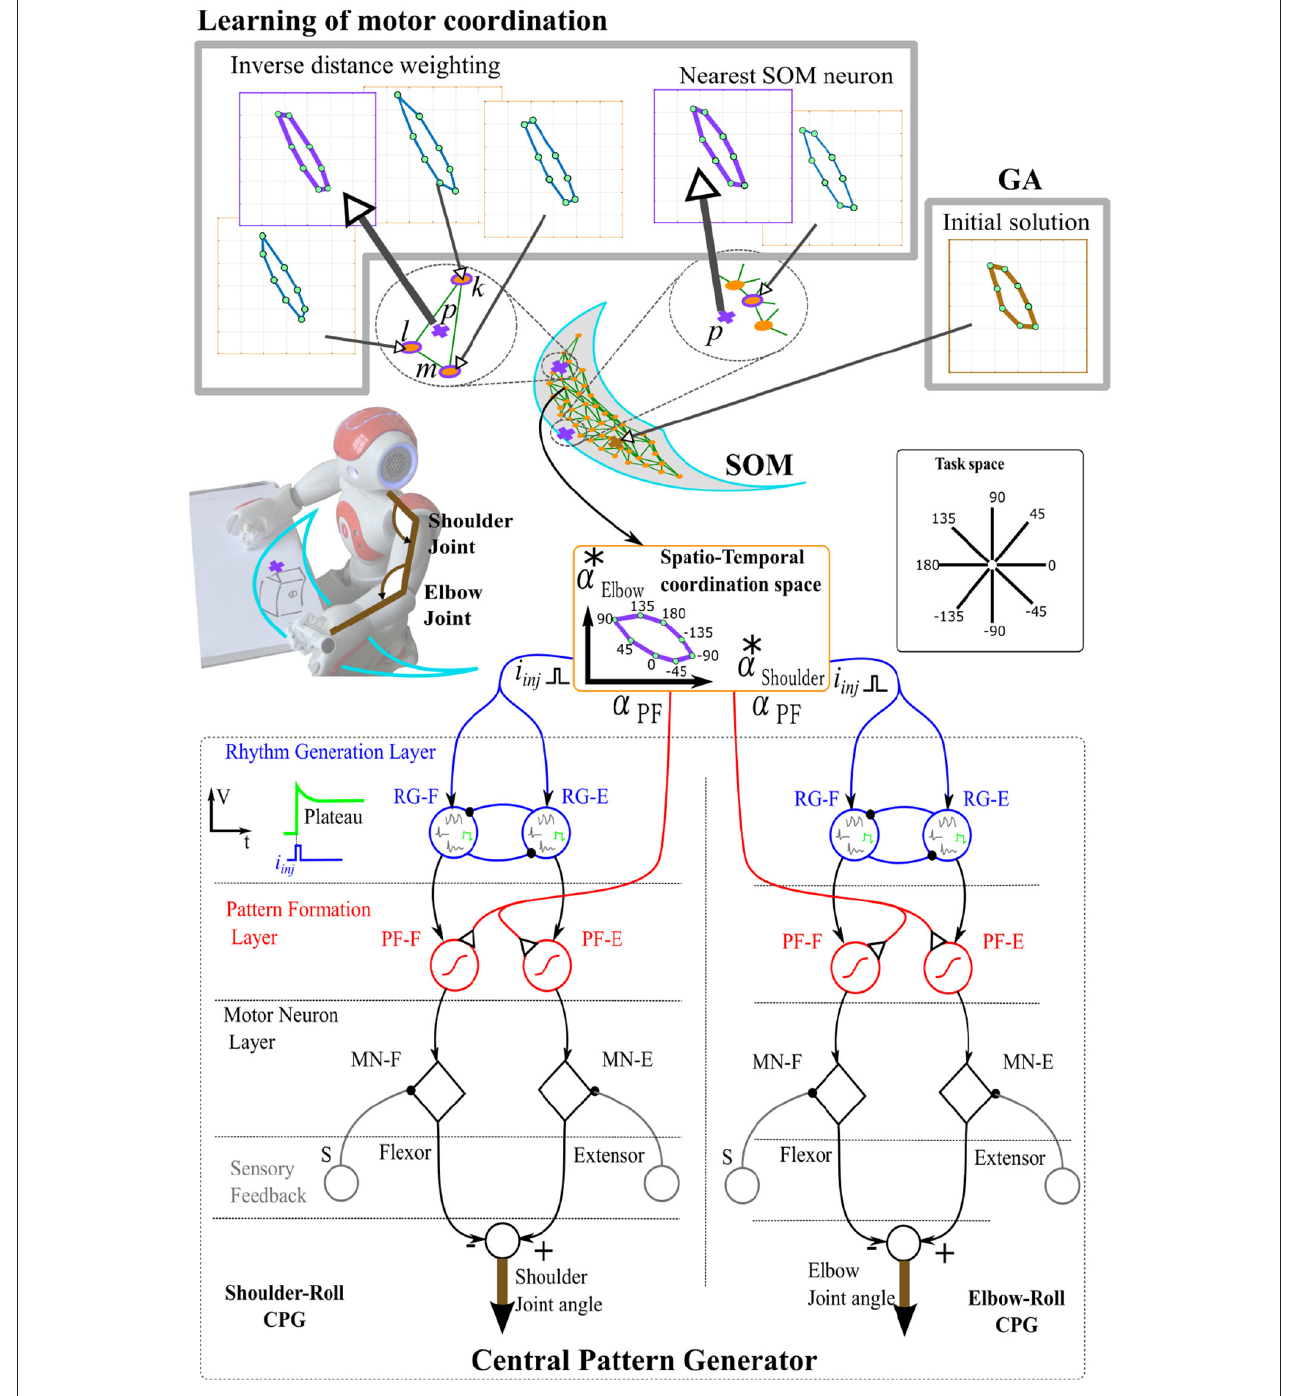
FIGURE 1 | An illustration of the learning algorithm in combination with the Central Pattern Generator. Plateau patterns are selected at the Rhythm Generation layer (RG), other patterns can also be generated such as quiescent, oscillation, and almost oscillation (Rowat and Selverston, 1997). The temporal coordination is specified by the injected currents in RG neurons, while the spatial coordination is determined by the slope α PF of the sigmoid activation function in the Pattern Formation layer (PF). A Self-Organizing Feature Map (SOFM) represents the workspace, and, furthermore, coordination parameters ( α * ShoulderRoll , α ∗ ElbowRoll ) are associated to each of its neurons, where they are used to coordinate a line drawing action from any given starting point of the workspace. The motor coordination acquisition is done by applying a multi-objective genetic algorithm, whose result is used later for the transfer algorithm in the learning of motor coordination. As shown in the learning of motor coordination block, the estimation of the coordination parameters is done either by Inverse Distance Weighting (IDW) interpolation or nearest SOM neuron.